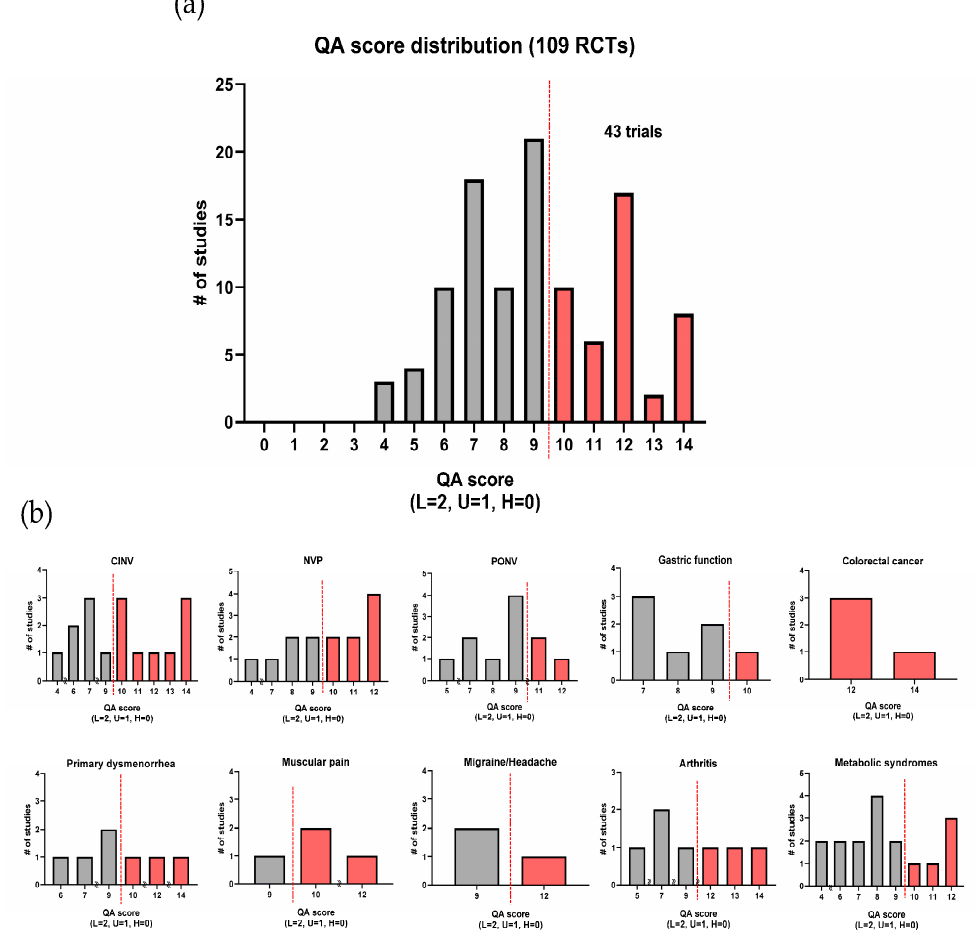
Figure 4. Distribution of ginger randomized controlled trials (RCTs) based on quality assessment (QA) score: a bright color indicates a ‘high quality of evidence,’ whereas a dark color indicates the opposite. ( a ) In total, 43 RCTs were addressed to have a high quality of evidence, and ( b ) each important function was evaluated (CINV: chemotherapy-induced nausea and vomiting; NVP: nausea and vomiting of pregnancy; PONV: postoperative nausea and vomiting).